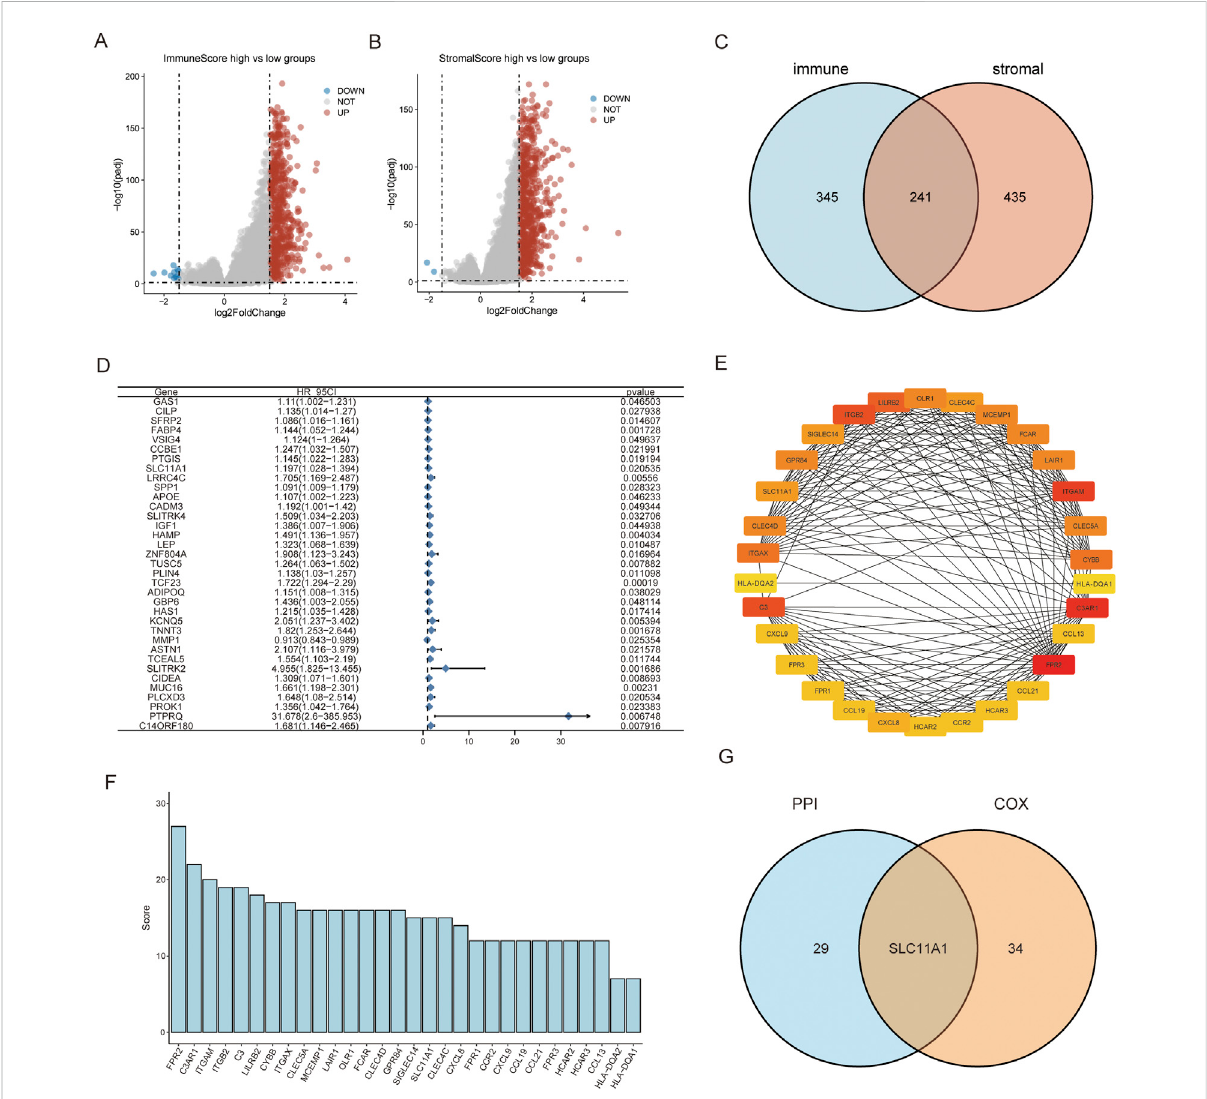
FIGURE 2 SLC11A1 was identi fi ed as the hub gene for TME. (A,B) Volcano plots for DEGs identi fi ed by comparison of high-ImmuneScore vs. low- ImmuneScore groups and high-StromalScore vs. low-StromalScore groups. (C) Venn plot showed 241 common factors with the DEGs from ImmuneScore and StromalScore analyses. (D) Thirty- fi ve factors with p -value < 0.05 by univariate Cox analysis. (E) Thirty genes with the screened with MNC algorithm. (F) The bar chart showed MNC scores of the 30 genes. (G) SLC11A1 was identi fi ed in the intersection of the two